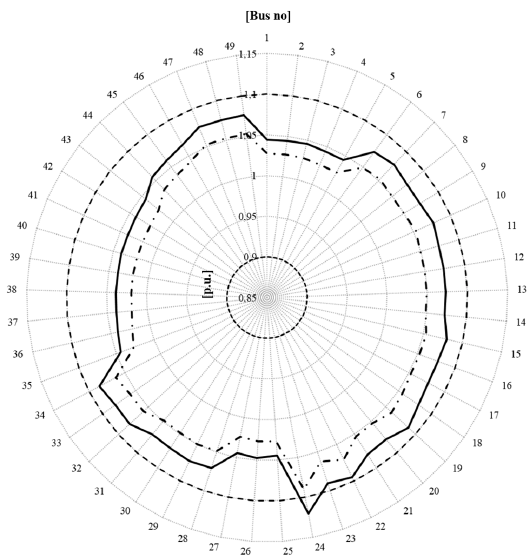
Figure 11. Network voltage profile with (dotted-dashed line) and without (solid line) the voltage controllers. Dashed lines refer to voltage limits.